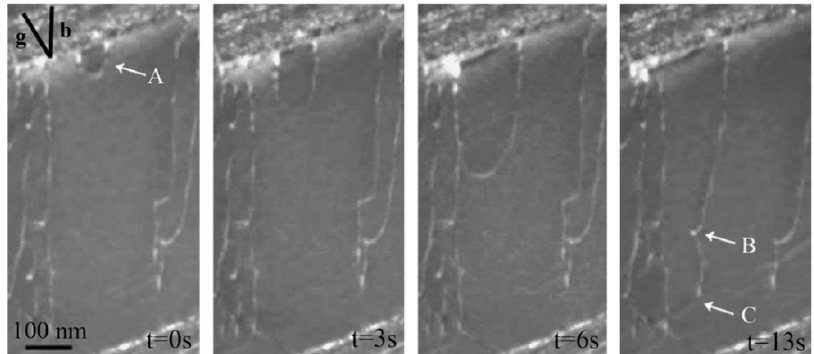
Figure 11. Emission of α dislocation loop from an α s / β interface during an in situ TEM observation. (A: the initial position of dislocation emission, B: edge dislocation departs from screw dislocation because of pinning, C: emergence of dislocation loop) [85]. Reprinted with permission from Ref. [85]. Copyright 2007, Acta. Mater.